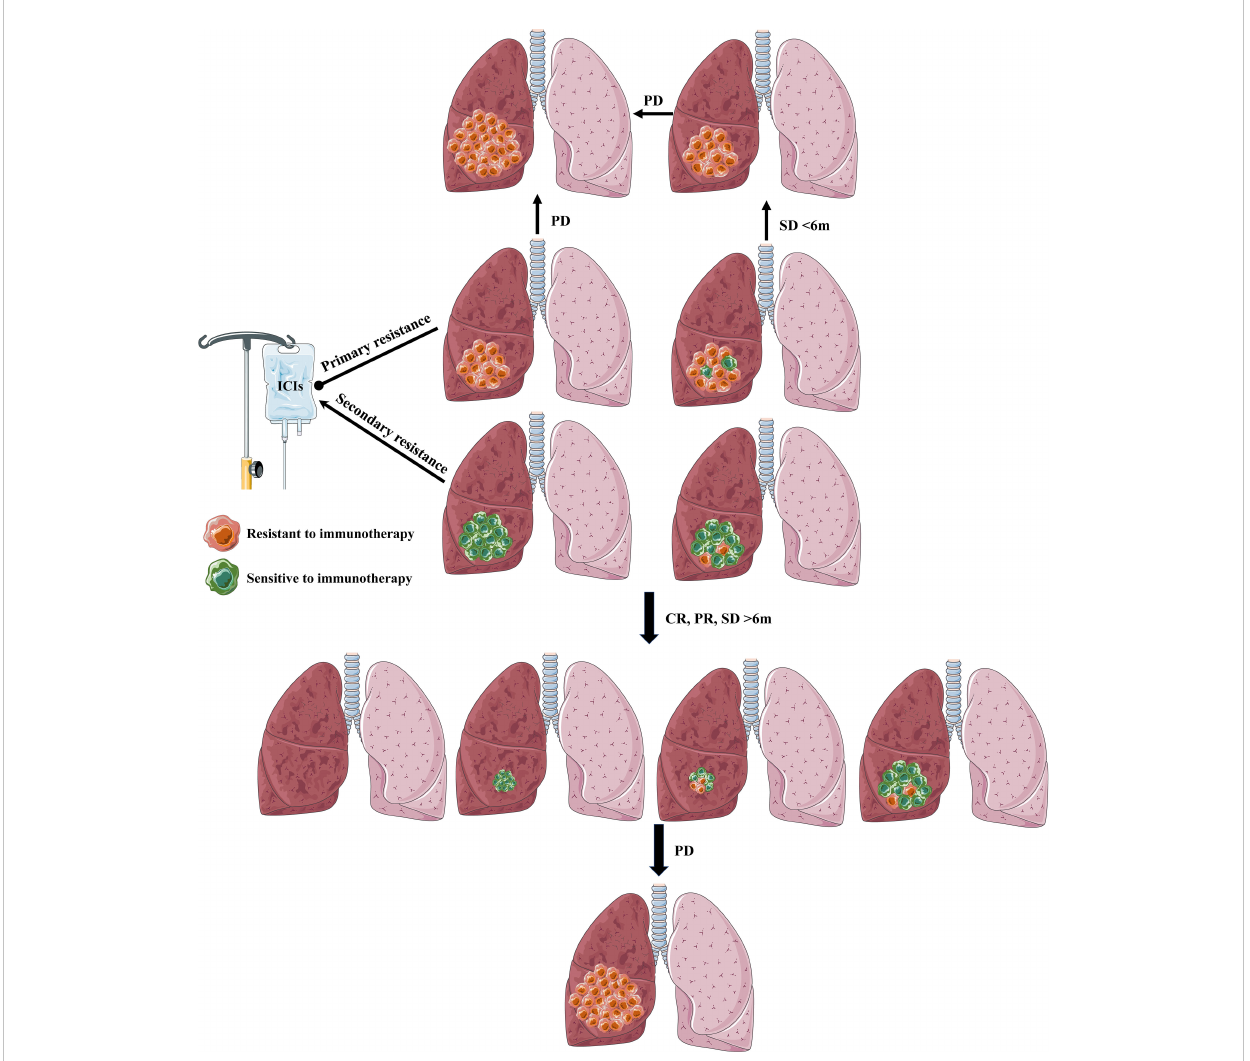
FIGURE 3 The de fi nition and explanation of primary resistance and secondary resistance. Primary resistance: tumors in primary resistance NSCLC patients may contain no or only a few sensitive tumor cells to immunotherapy, which may present no active immune response (PD) or activate antitumor immune response followed by swiftly submerging by intricated mechanism (SD<6 months). Secondary resistance: When tumors contain no or only a few resistive tumor cells to immunotherapy, NSCLC patients will show a favorable and lasting response (CR, PR, SD) to immunotherapy (>6 months). However, some will form secondary resistance when tumor cells lose active response to immunotherapy by complicated